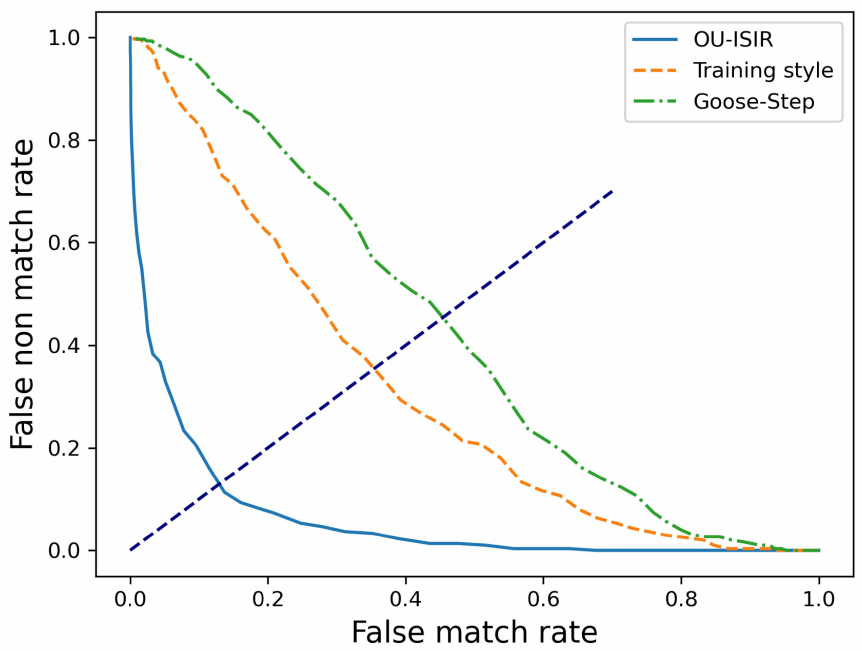
Figure 3. DET curve on different datasets; the threshold grow with 100